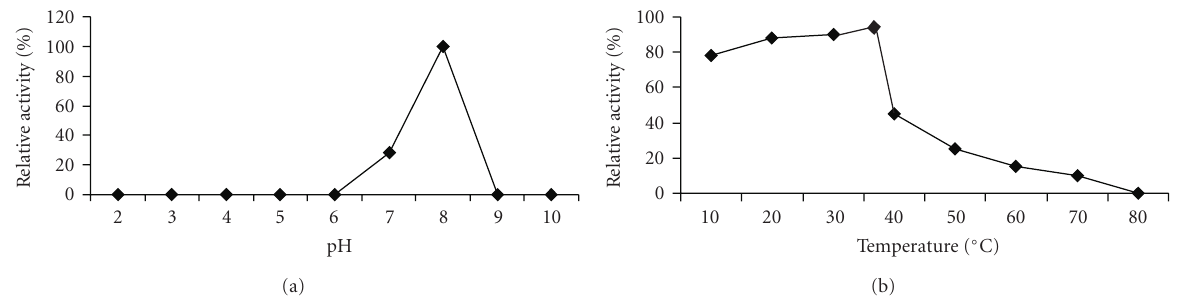
Figure 4: E ff ect of pH and temperature on enzyme activity. Purified urate oxidase was incubated under di ff erent pHs (a) and temperatures (b) and assayed as described in Section 2.